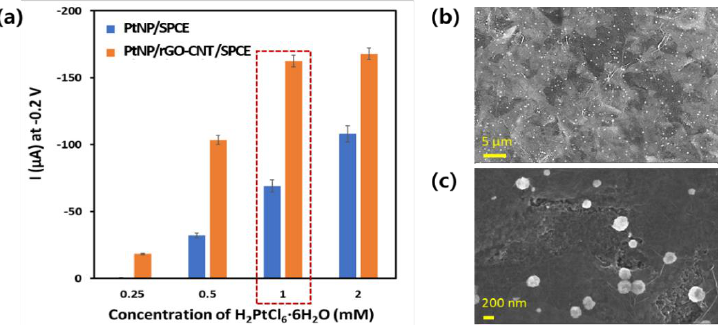
Figure 2. ( a ) Changes in cathodic current of PtNP / rGO–CNT / SPCE and PtNP / SPCE at − 0.2 V (vs. Ag pseudo-reference electrode) according to the concentration of H 2 PtCl 6 · 6H 2 O in N 2 -saturated PBS (0.1 M, pH7.4)solutioncontaining2.5mMH 2 O 2 and0.1MKCl. ( b )SEMimagesofPtNP / rGO–CNT / PtNP / SPCE and ( c ) higher magnification image of ( b